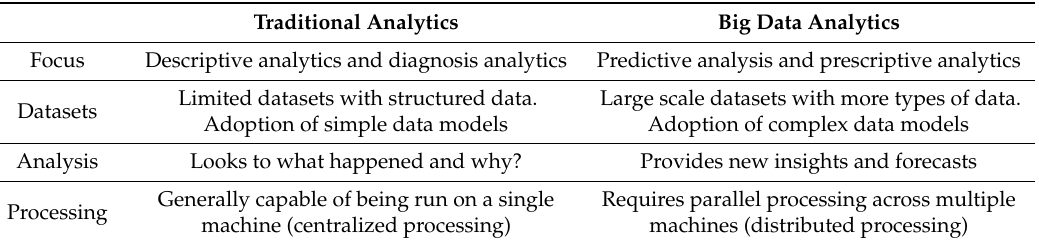
Table 3. Traditional analytics vs big data analytics (adapted from